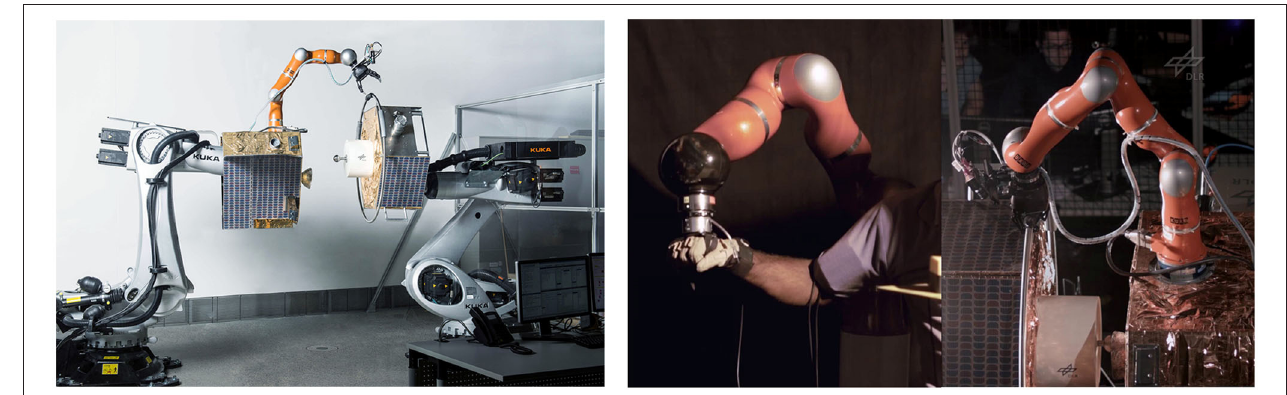
FIGURE 15 | (Left) The On-Orbit Servicing facility at DLR. (Right) The haptic device and the remote robot are of the same type of collaborative